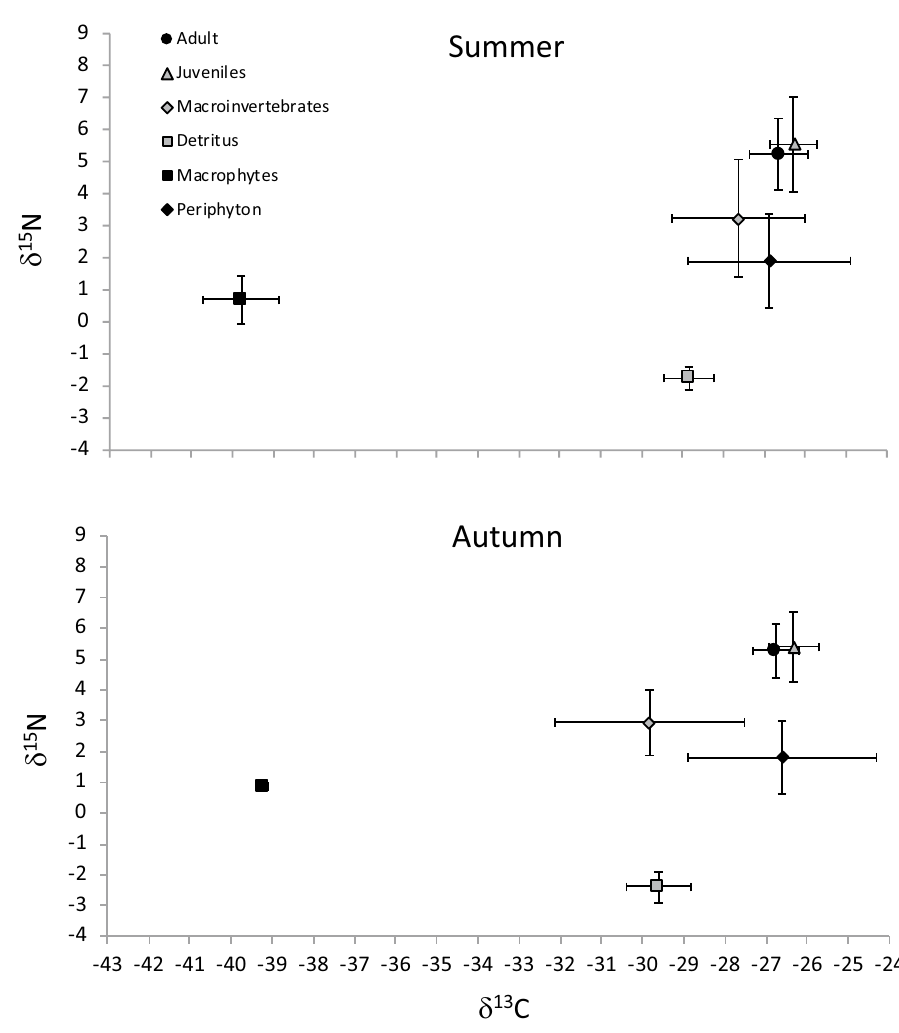
Figure 1. Mean (± SD) carbon and nitrogen stable isotope values (‰) of the signal crayfish size classes and of their putative food